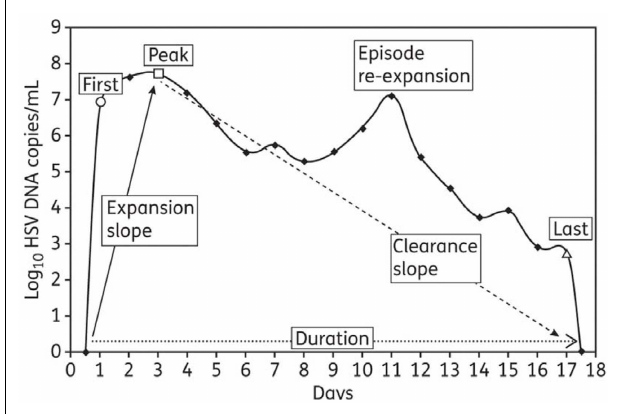
FIGURE 1 | Shedding episode classification scheme: from Schiffer et al., JAntimicrob Chemother. 2011;66(11):2593–600. (29).